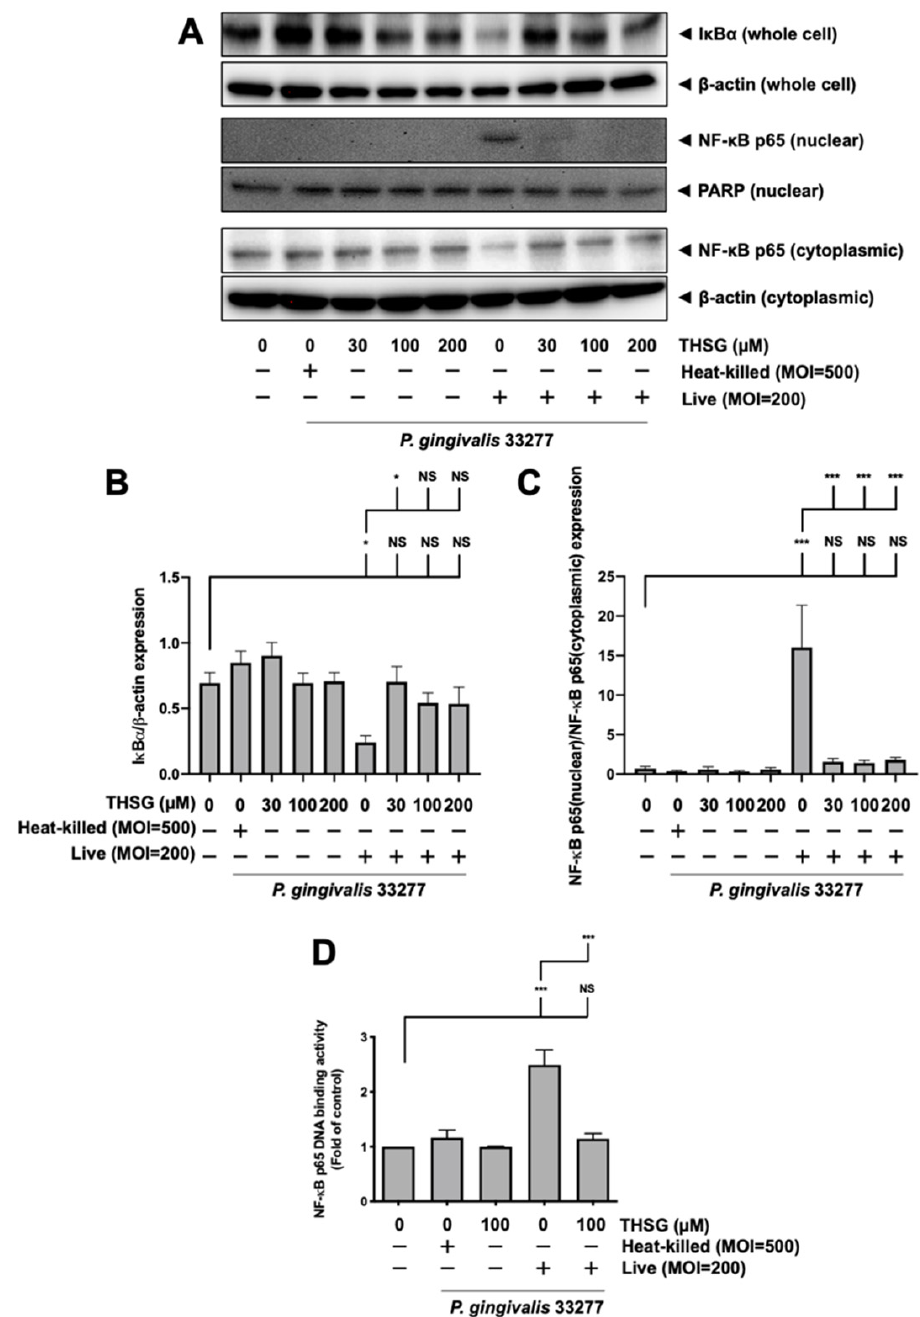
Figure 3. Suppression of NF- κ B activation by THSG in P. gingivalis -infected bEnd.3 cells. THSG (0, 30, 100, or 200 μ M) was added to cells 2 h before 90 min P. gingivalis infection (heat-killed MOI 500 or live MOI 200). Cell lysates were collected after 15 min of additional incubation with a fresh me- dium. ( A ) I κ B α protein from whole-cell lysate and NF- κ B p65 protein from nuclear and cytoplasmic fraction were analyzed by Western blot analysis. The quantitative results are shown in ( B , C ), re- spectively. ( D ) DNA binding activity of NF- κ B p65 was determined by the transcription-factor assay and calculated in the fold of control. Data in bar graph are expressed as mean values ± SEM (n = 4).